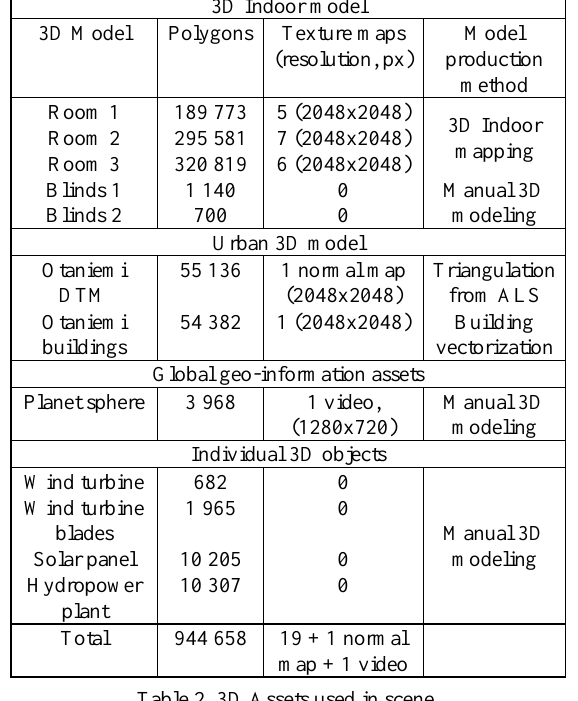
Table 2. 3D Assets used in scene.